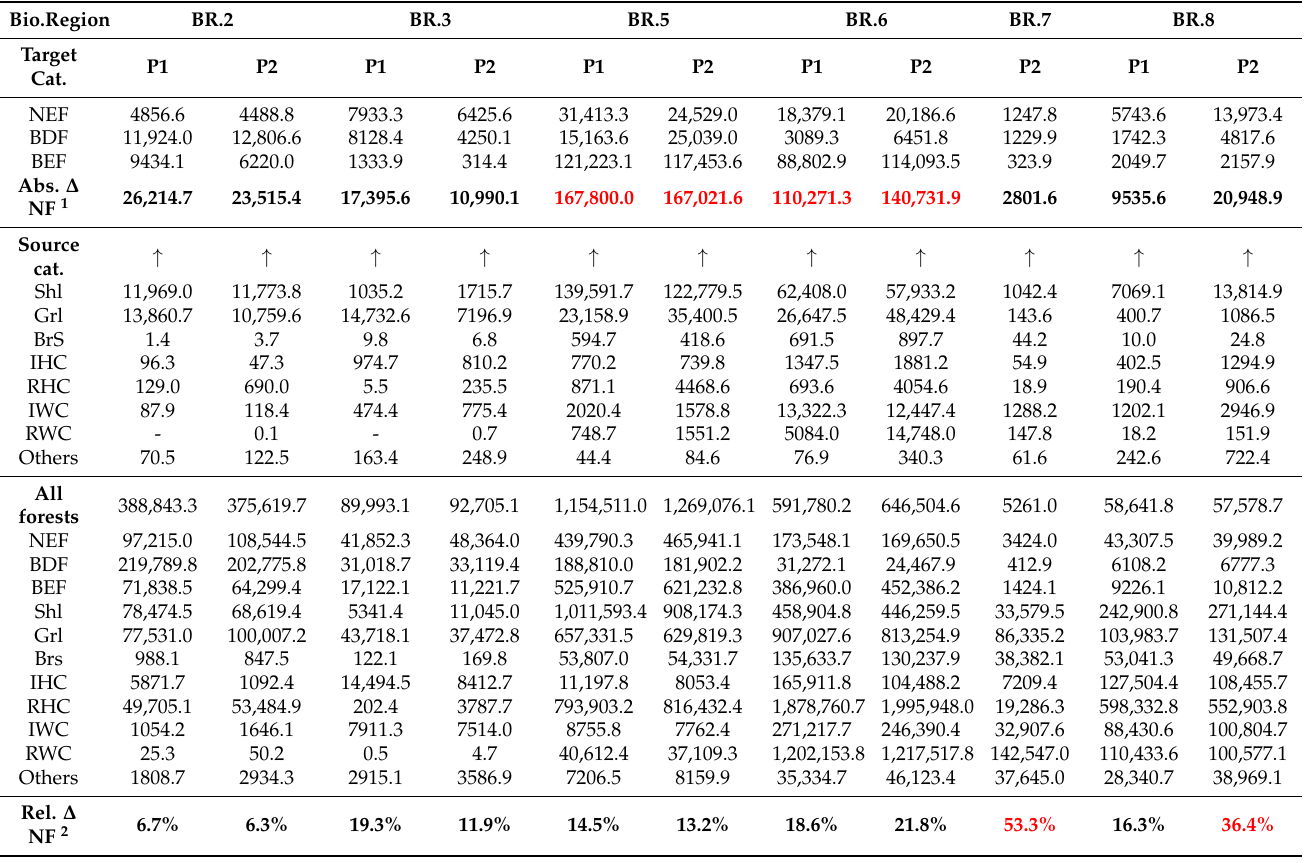
Table 3. New forest dynamics in absolute and relative values. The source categories’ transitioning area (all figures in ha) towards the target NF group categories (in the upper part of the table) is detailed and disaggregated by the finally modeled BRs and analysis period (P1, P2). In the lower part of the table, figures related to all forests are given to provide final relative